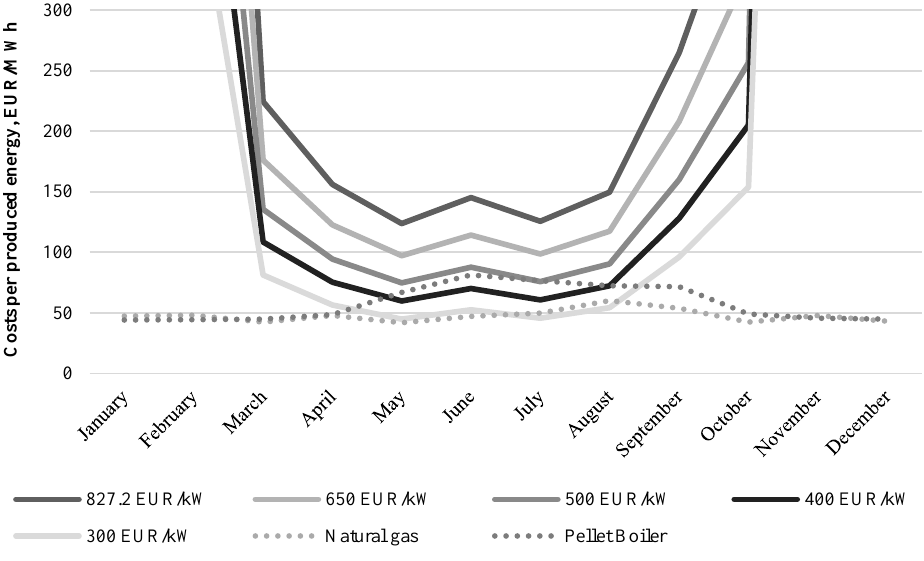
Fig. 5. Costs per produced energy based on monthly